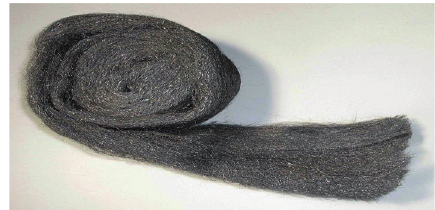
Figure 2: The SWF sample in this